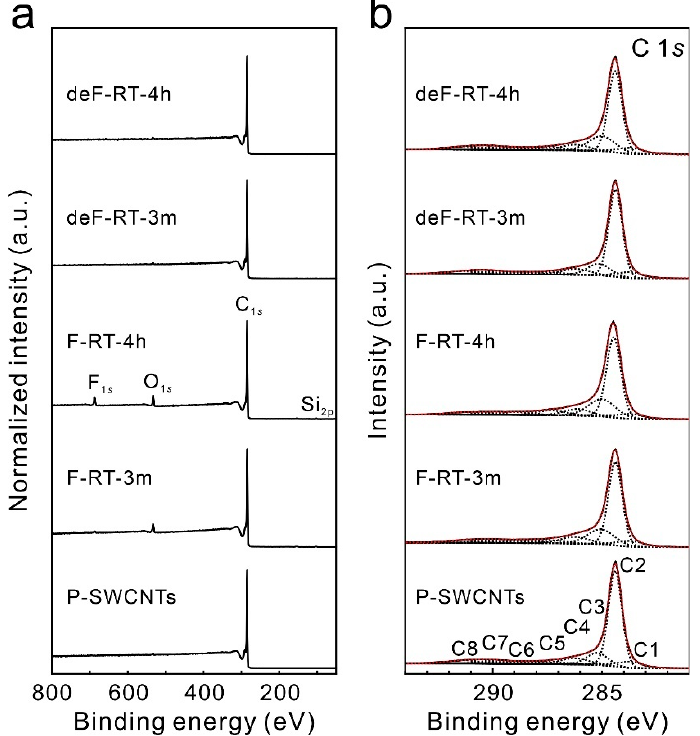
Figure 2. ( a ) X-ray photoelectron spectroscopy (XPS) wide and ( b ) XPS C 1 s narrow spectra of purified, fluorinated, and defluorinated single-walled carbon nanotubes (P-SWCNTs, F-SWCNTs, and deF-SWCNTs, respectively). The black and red dotted lines represent deconvoluted peaks and fitted curves, respectively. Table 1. Elemental concentrations of P-SWCNTs, F-SWCNTs, and deF-SWCNTs. The binding energies and chemical compositions of each sample were determined at three different positions to obtain the average value. Chemical Composition (at.%) Component of Fluorine Species